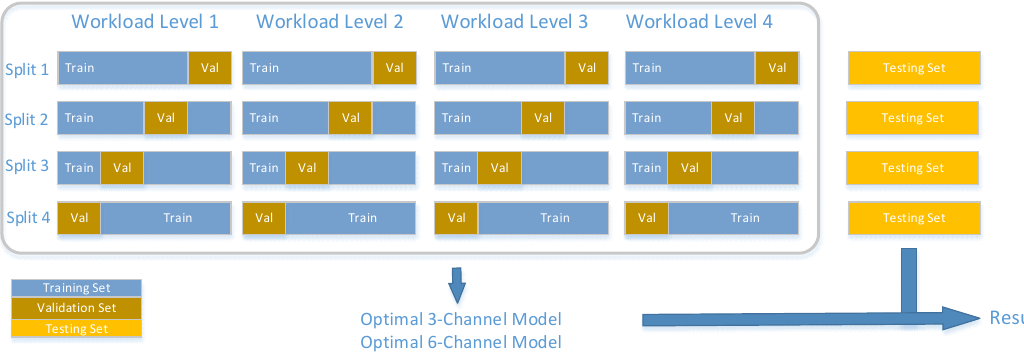
Figure 5. The process of stratified 4-fold cross validation and final testing. Training set and validation set accounts for 80% which is used to find the optimal 3-channel model and 6-channel model. Then the remaining 20% testing set was used to calculate the final